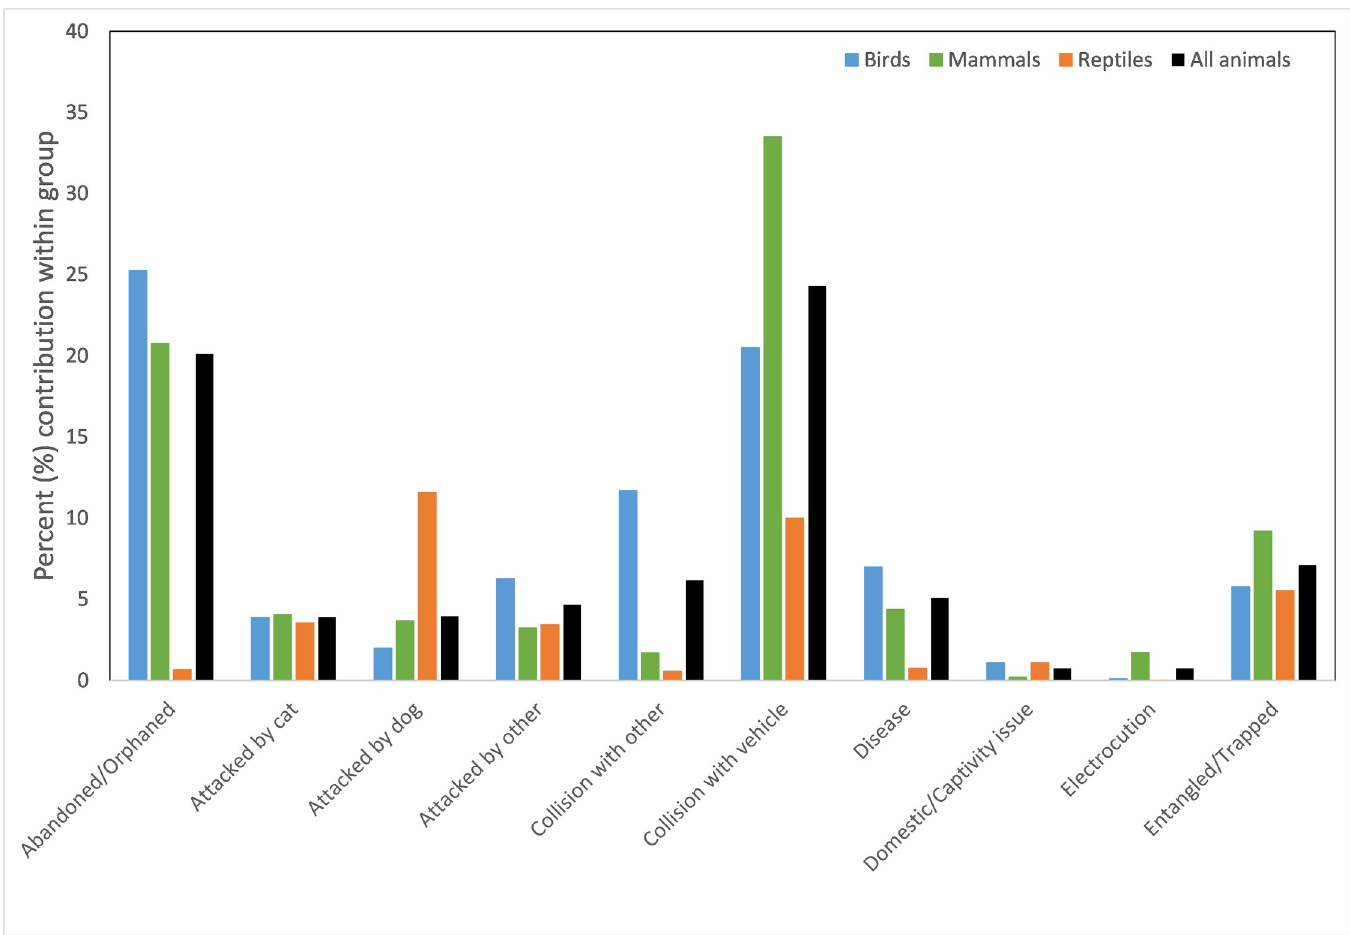
Fig 2. Cause for rescue (%) within each animal group, for top 10 highest ranked causes across all animals.